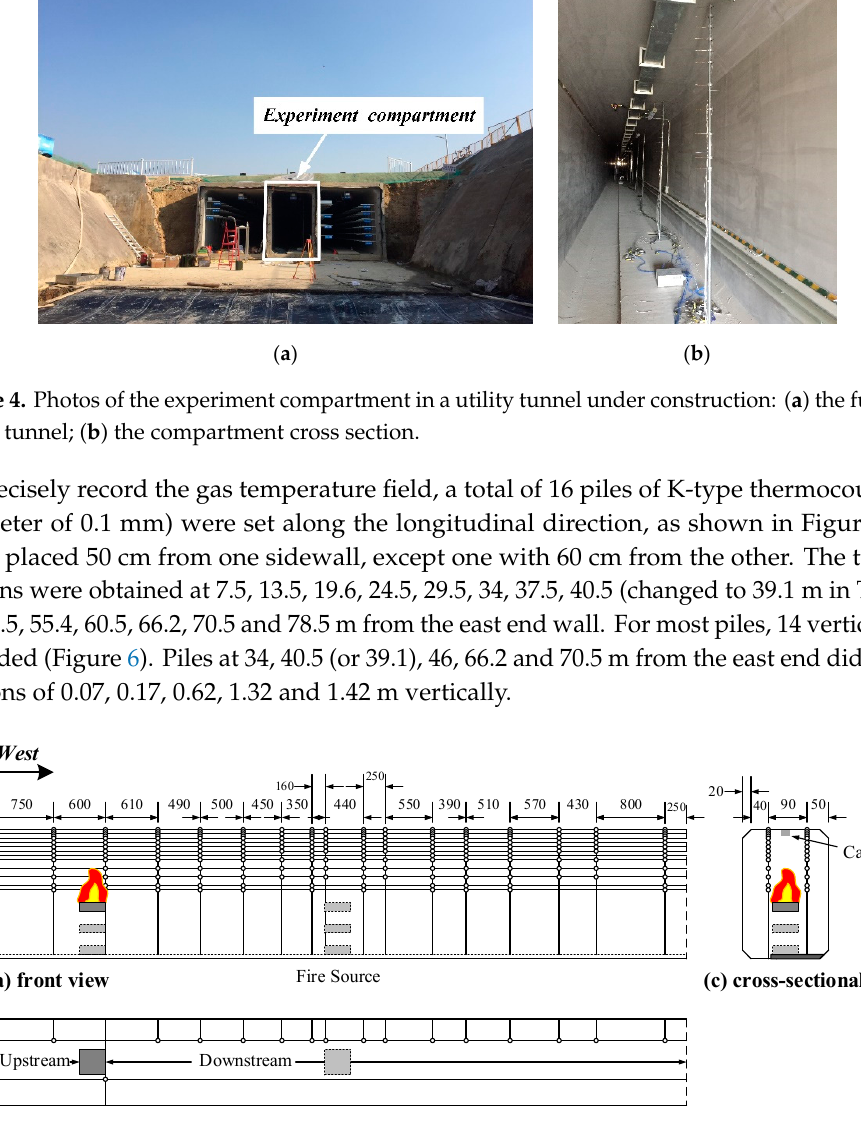
Figure 3. Cross-section of the ZRC-YJV-8.7/10 3 × 95 mm 2 power cable.